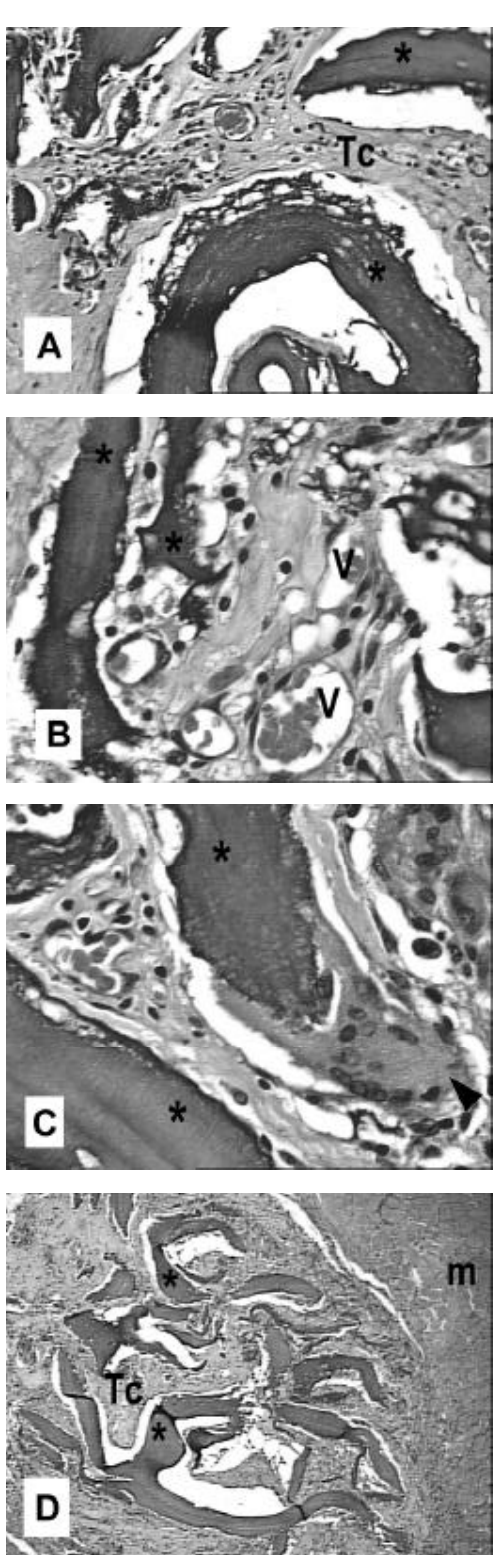
FIGURA 4 - Fotomicrografia do período de 21 dias: A) Material (*) envolvido por tecido conjuntivo (Tc) frouxo, HE, 96x; B) Vasos sangüíneos (V) em maior aumento, HE, 384x; C) Células gigantes (cabeça de seta) em íntimo contato com o material (*), HE, 384x; D) Vista geral do material (*), observado-se a absorção deste, HE,